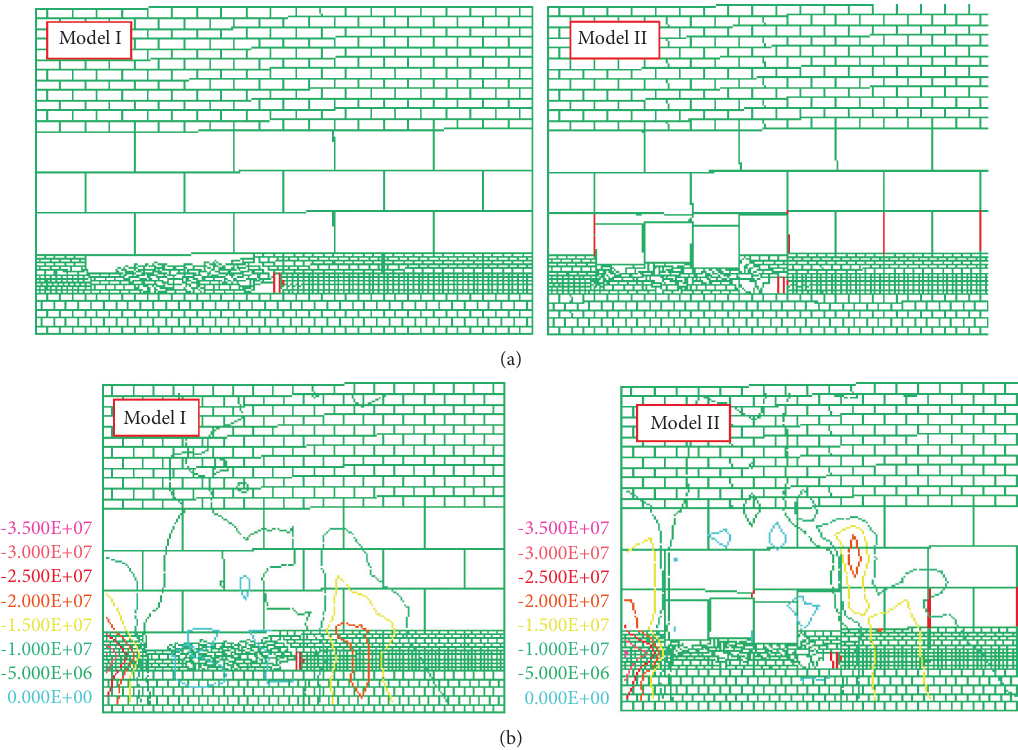
Figure 10: Working face advancing to 80 m. (a) Overlying strata fracture characteristics of the model. (b) Vertical stress characteristics of the model.